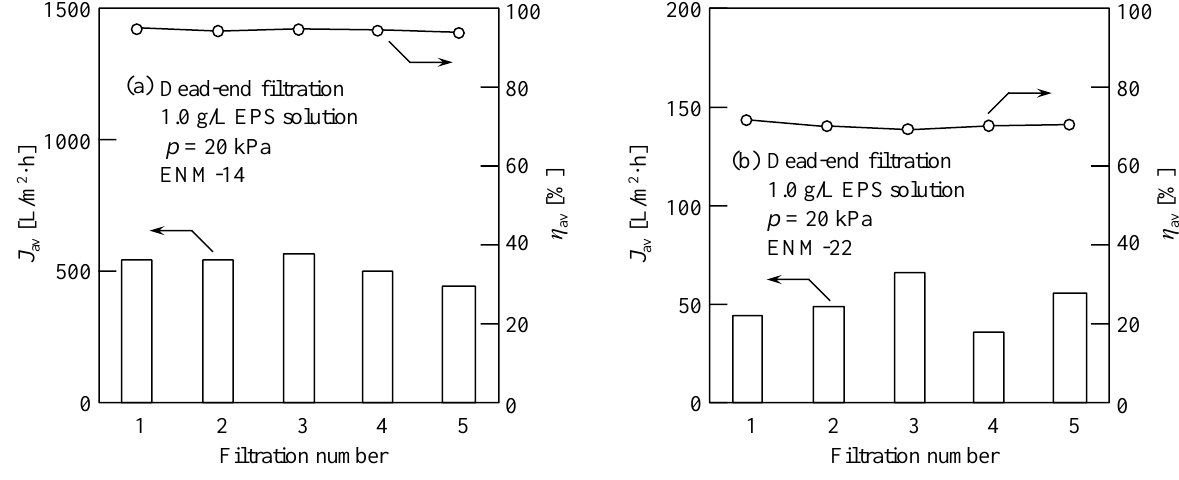
Figure 9. Average water flux ( J av ) and average EPS recovery rate ( η av ) during the dead-end filtration of a 1.0 g/L EPS solution with a filtration pressure ( p ) of 20 kPa using the ( a ) ENM-14 and ( b ) ENM-22 specimens. Five filtration cycles were carried out wherein the membrane was cleaned using ultrasonic irradiation for 10 min between filtrations. The evaluated data were obtained for the cumulative filtrate volume per unit membrane area, v = 2 cm.